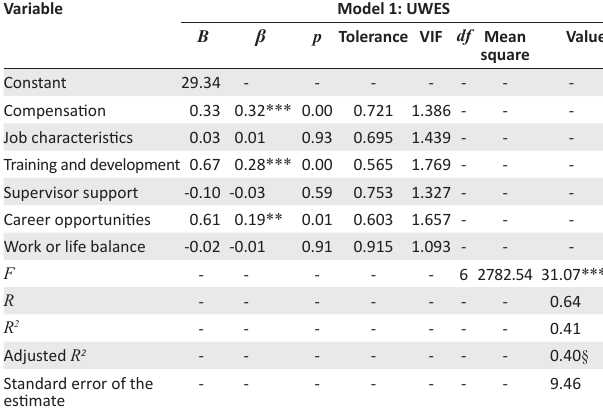
TABLE 4: Multiple regression analysis: Retention Factors Measurement Scale as a predictor of Utrecht Work Engagement Scale ( N = 278).